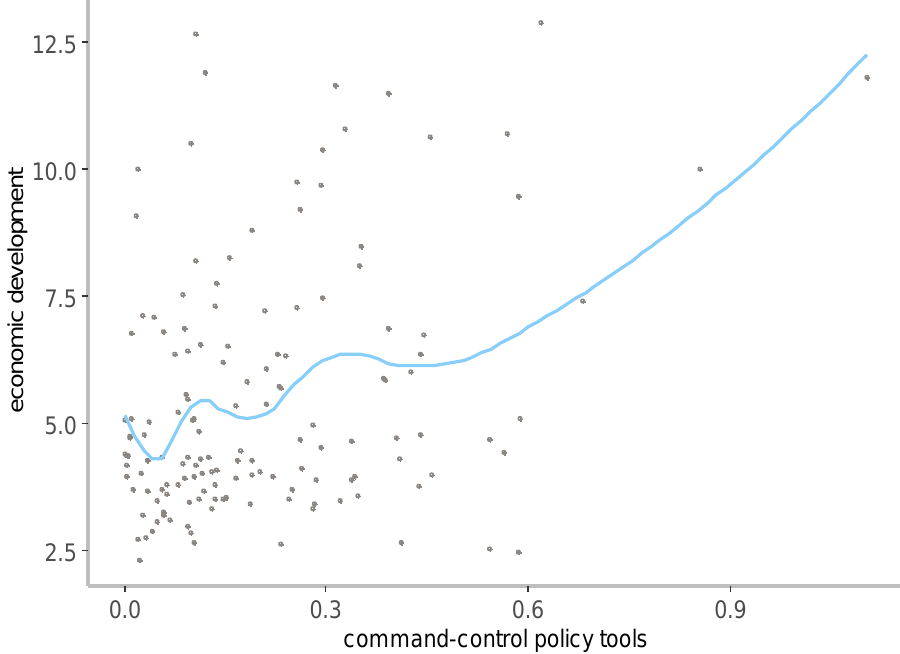
Figure 2. Scatterplot between command-control policy tools and economic